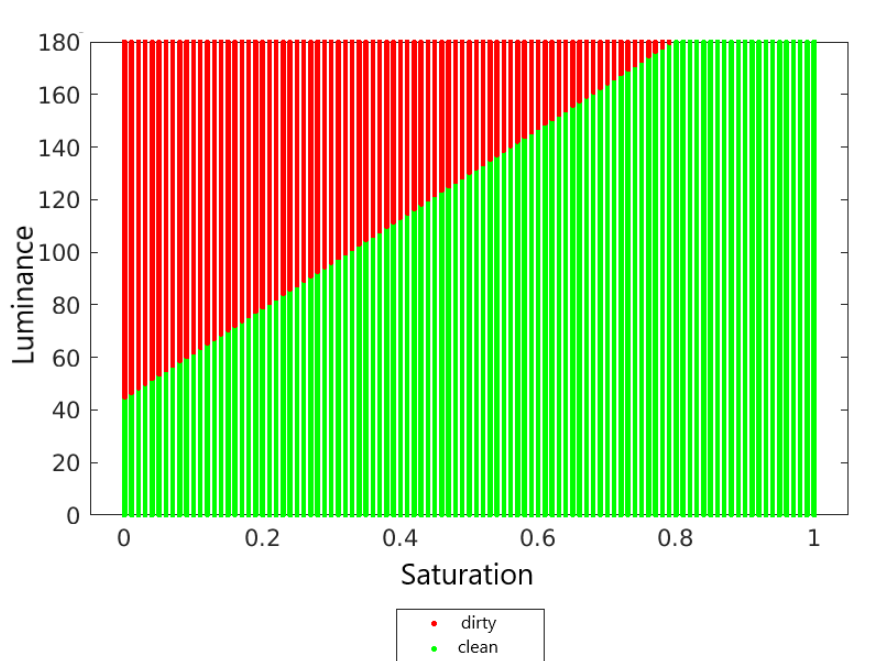
Figure 11. Decision surface for the linear Fischer